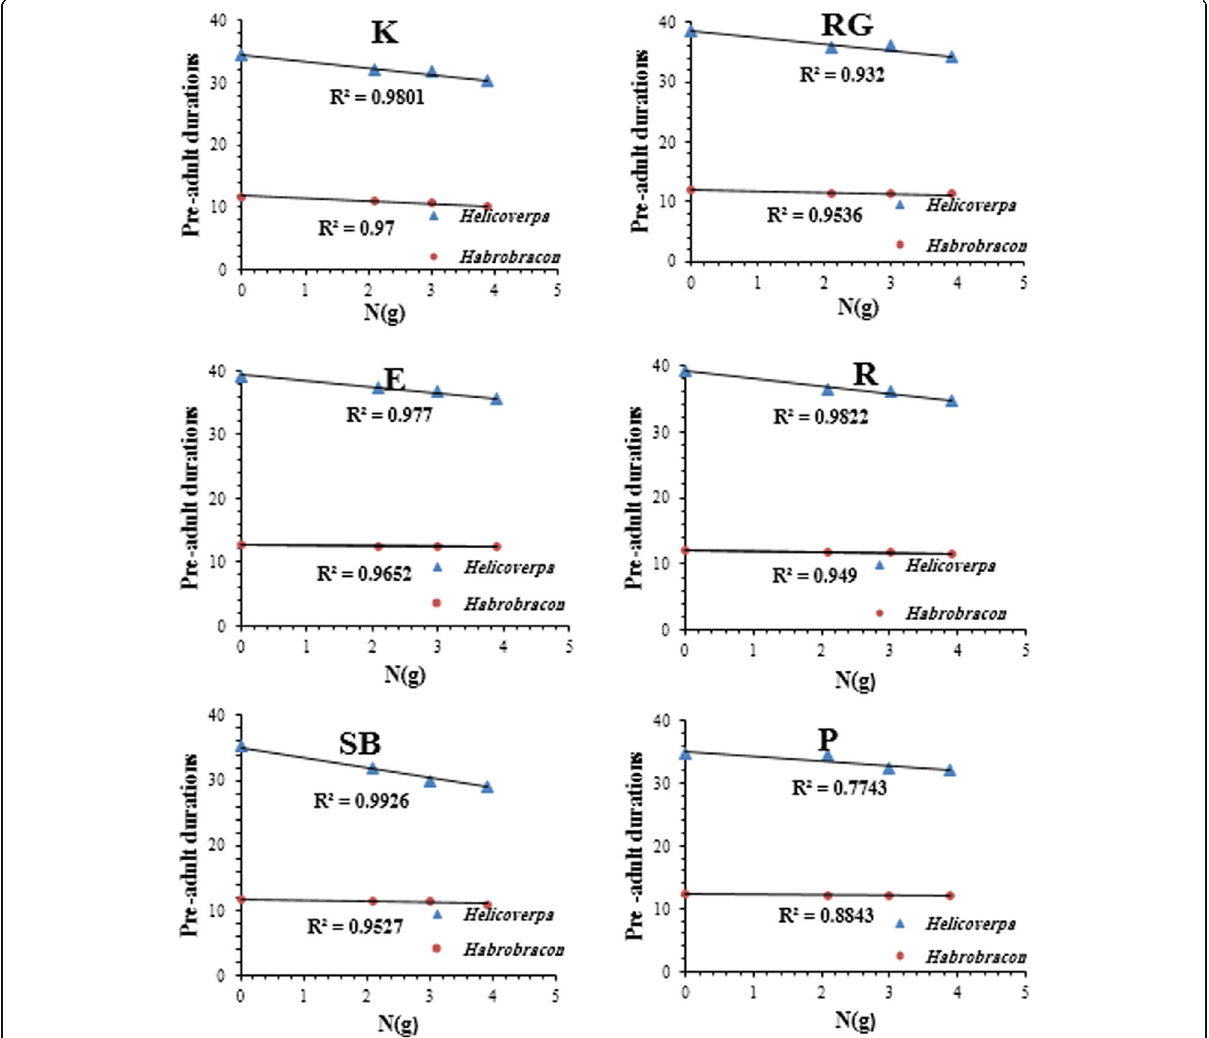
Fig. 1 Linear regression between pre-adult duration of H. armigera and H. hebetor on six tomato cultivars with four nitrogen levels. K=Kingston, RG=Riogrand, E=Earlyurbana, R=Redston, SB=Superstrin-B,